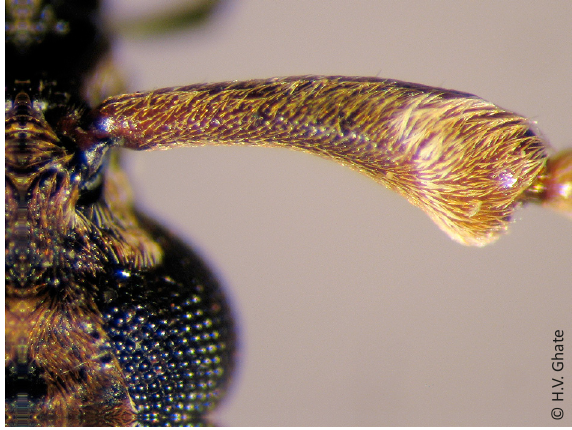
e a t G h V . H . © Image 4. Antennal scape of Apiocephalus in dorsal view; note the shape and pubescence.